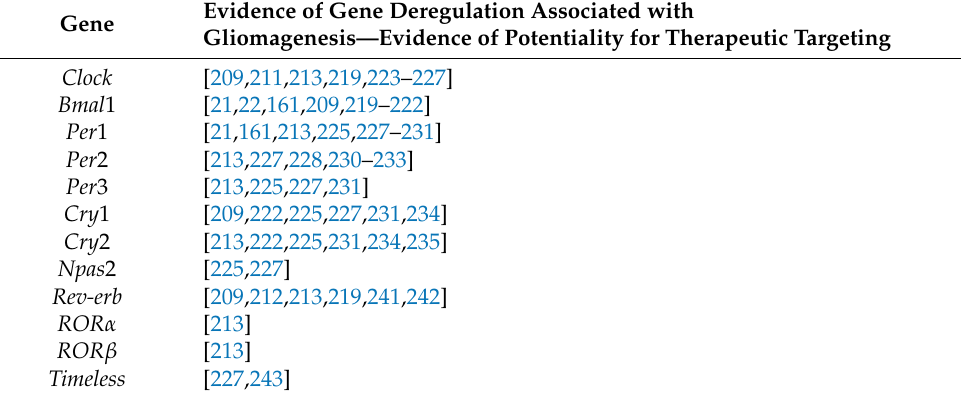
Table 3. Evidence of dysregulated clock gene expression in GBM. Evidence of Gene Deregulation Associated with Gene Gliomagenesis—Evidence of Potentiality for Therapeutic